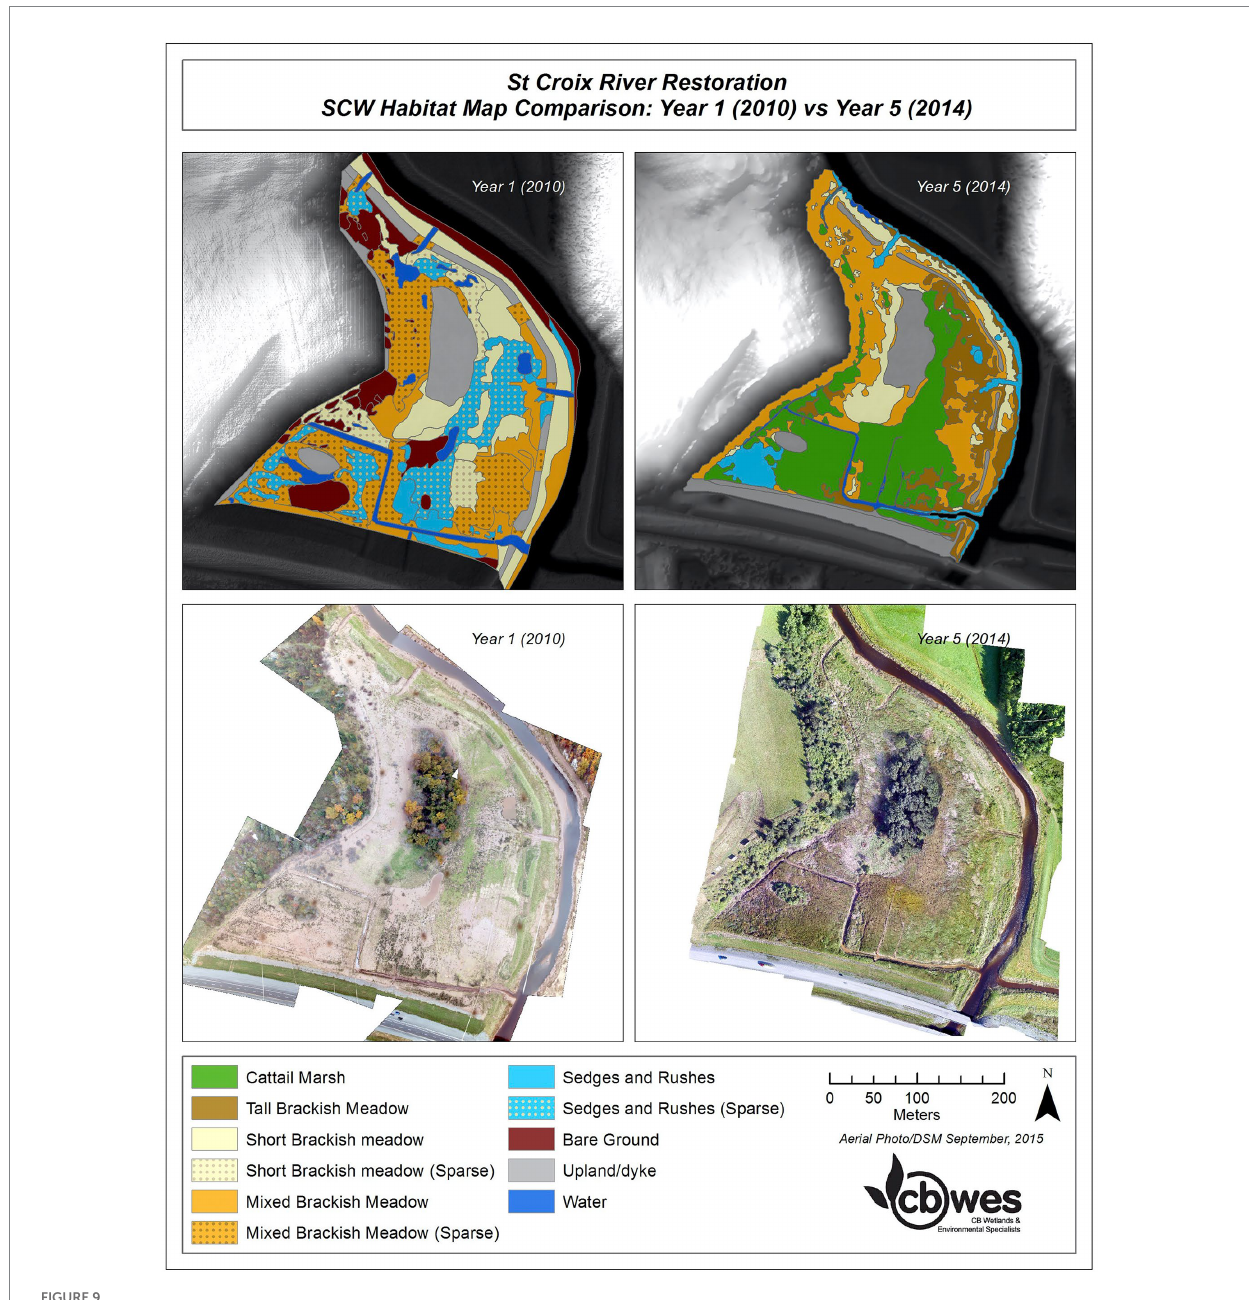
FIGURE 9 Habitat comparison at SC restoration site between Year 1 and Year 5 post